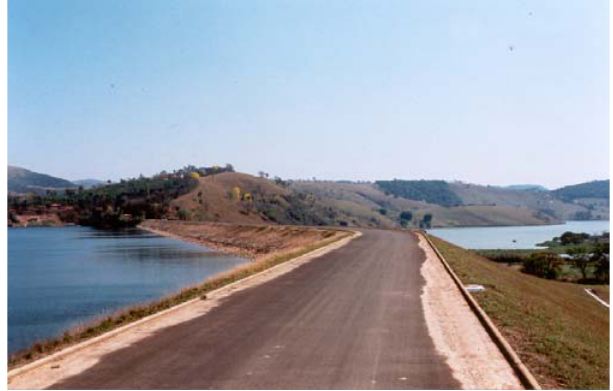
Fig. 2. Capitólio dam. The Furnas artificial lake is seen on the left side, and the lake formed by the damming of the rio Piumhi waterflow is seen on the right